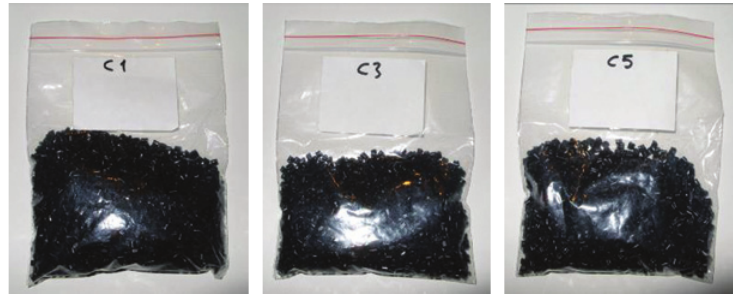
Figure 2 Produced MWNT/PC pellets.